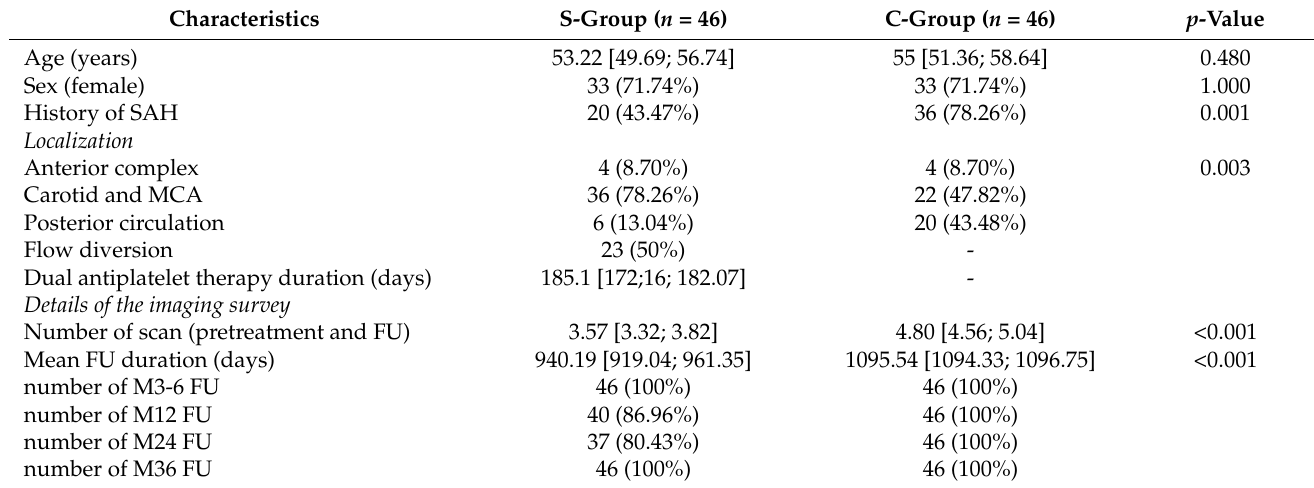
Table 1. Summary of the demographic, clinical, and radiological characteristics of the population.